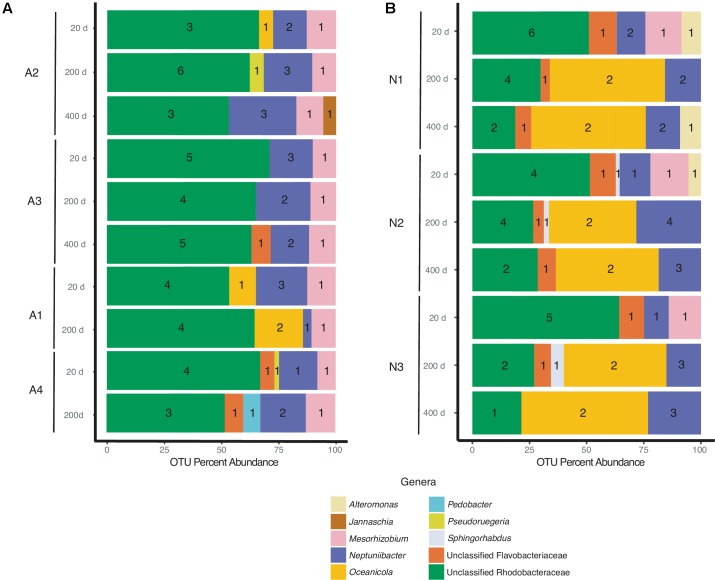
Bacterial composition of (A)
A. glacialis (A1, A2, A3, and A4) and (B)
N. longissima (N1, N2, and N3) across culturing time in the laboratory at the genus level. Numbers inside colored bars represents unique number of OTUs for a specific genus.